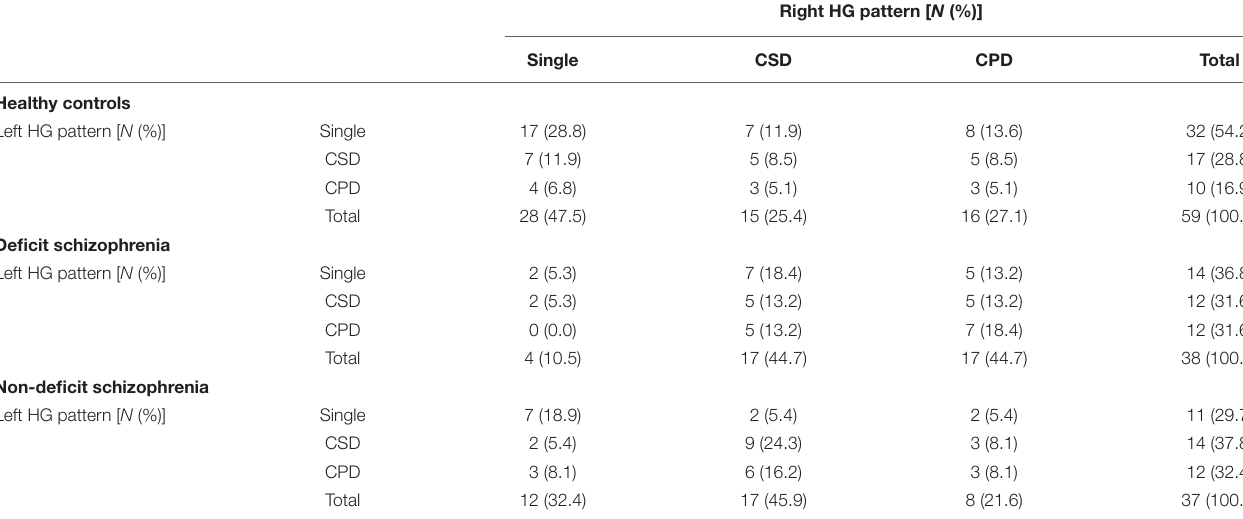
TABLE 2 | Gyrification pattern of Heschl’s gyrus (HG) in the study participants.